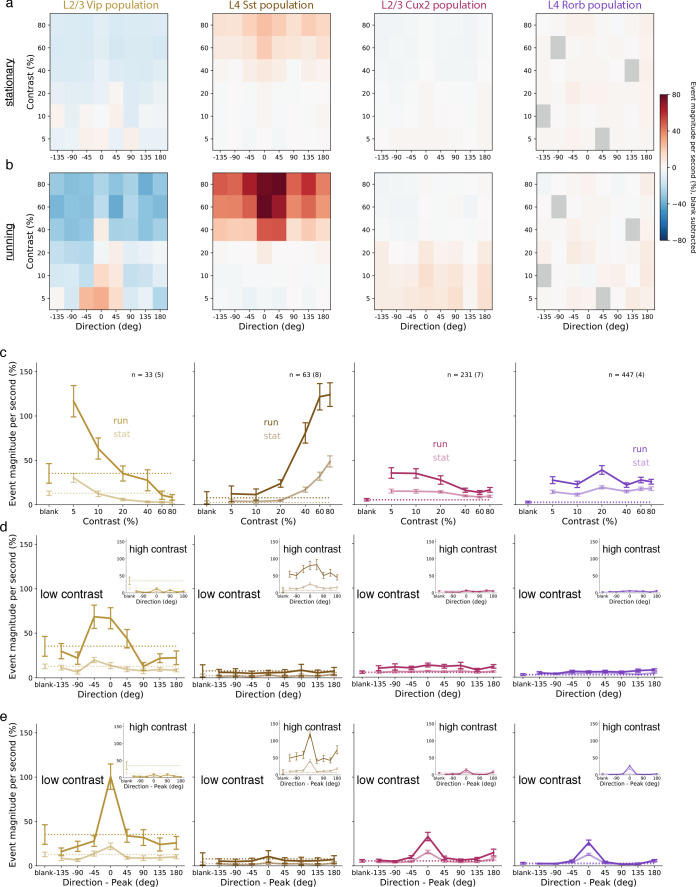
Average population responses of inhibitory, but not excitatory, cells are strongly biased toward front-to-back visual motion which is enhanced during locomotion.(a) Mean blank-subtracted event magnitude (a.u.; extracted events derived from dF/F trace) of all neurons from mice of each superficial Cre line during stationary periods. Gray boxes in Rorb plots indicate insufficient run and stationary data. (b) Same as a, for running periods. (c) Mean population contrast responses tuning at peak direction during stationary (faint lines) and running (bold lines) periods. (d) Mean population direction response tuning at low (5-10%) contrast. Insets: mean population direction response tuning at high (60-80%) contrast. (e) Mean single-neuron direction tuning (i.e. aligned to each neuron’s peak direction). Insets: mean single-neuron direction tuning at high (60-80%) contrast. All error bars are SEM. Sample size indicates number of neurons with number of experiments in parenthesis.